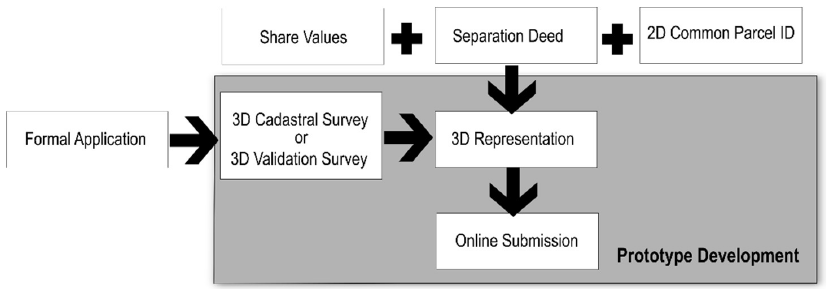
Figure 3. Strata registration: current and possible improvements.